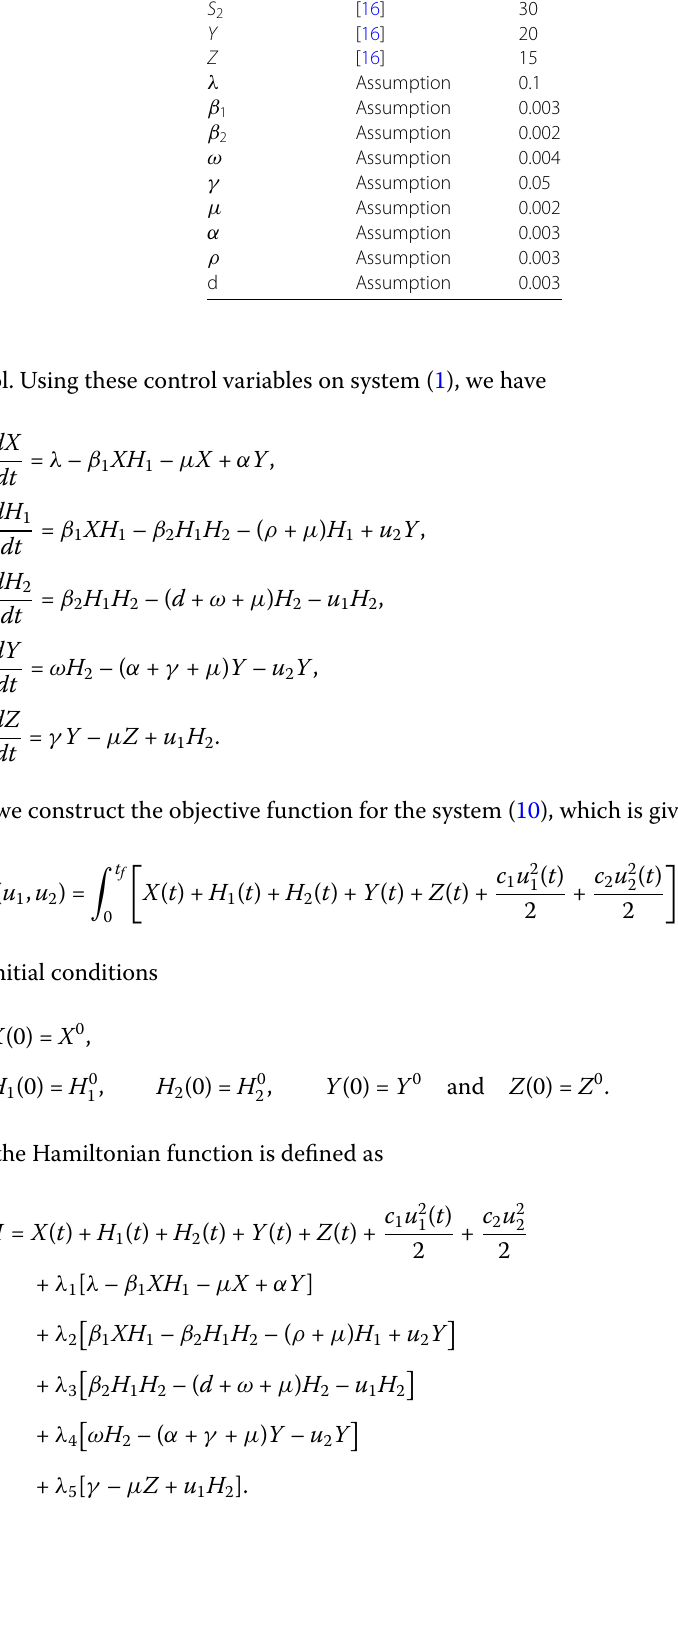
Table 2 Values of parameters for numerical solution Parameter Reference Value X [16] 68 S 1 [16] [16] 15 λ Assumption 0.1 β 1 Assumption 0.003 β 2 Assumption 0.002 ω Assumption 0.004 γ Assumption 0.05 μ Assumption 0.002 α Assumption 0.003 ρ Assumption 0.003